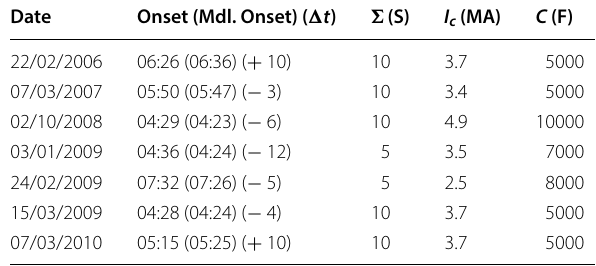
Table 1 WINDMI model parameters obtained when